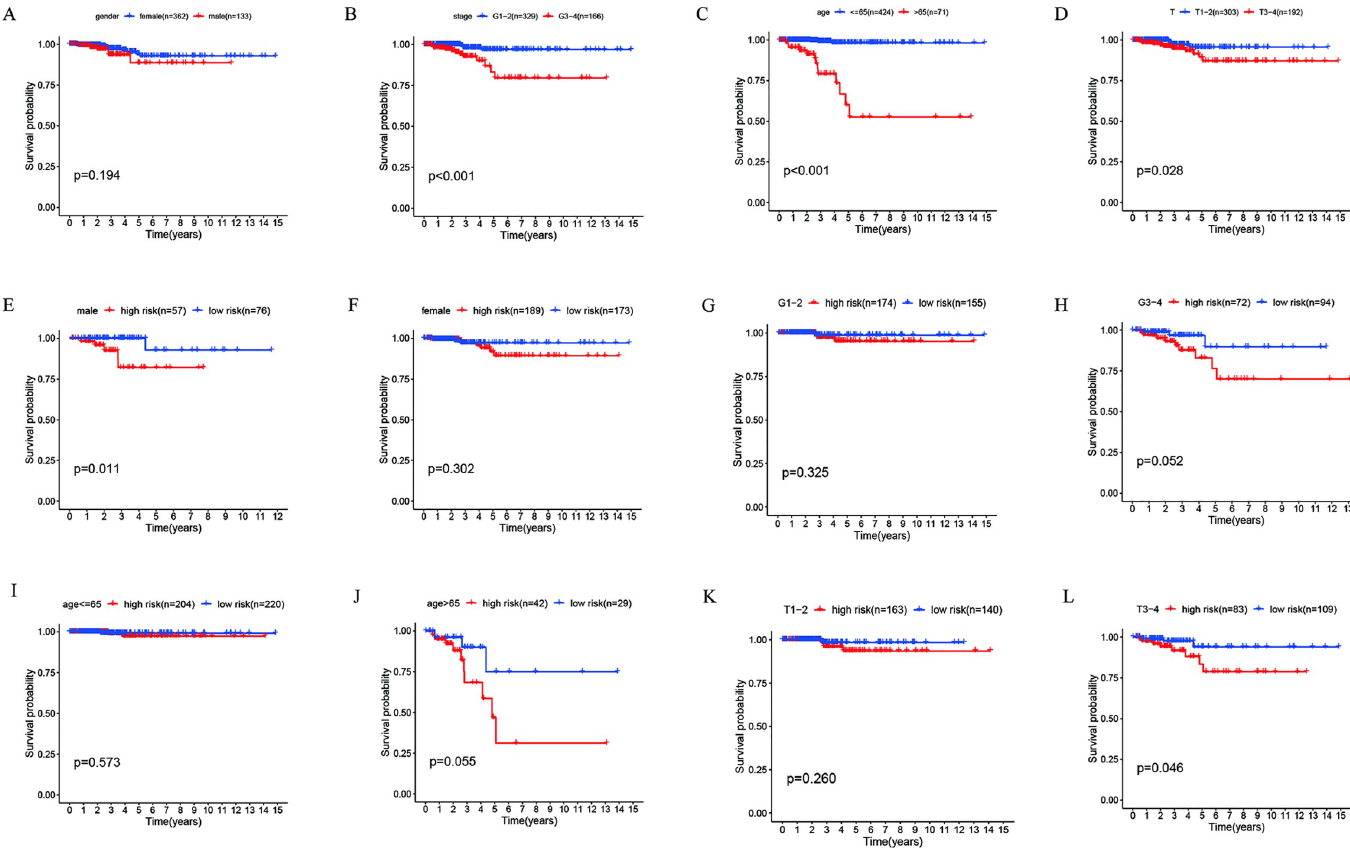
Fig 7. Clinical correlation